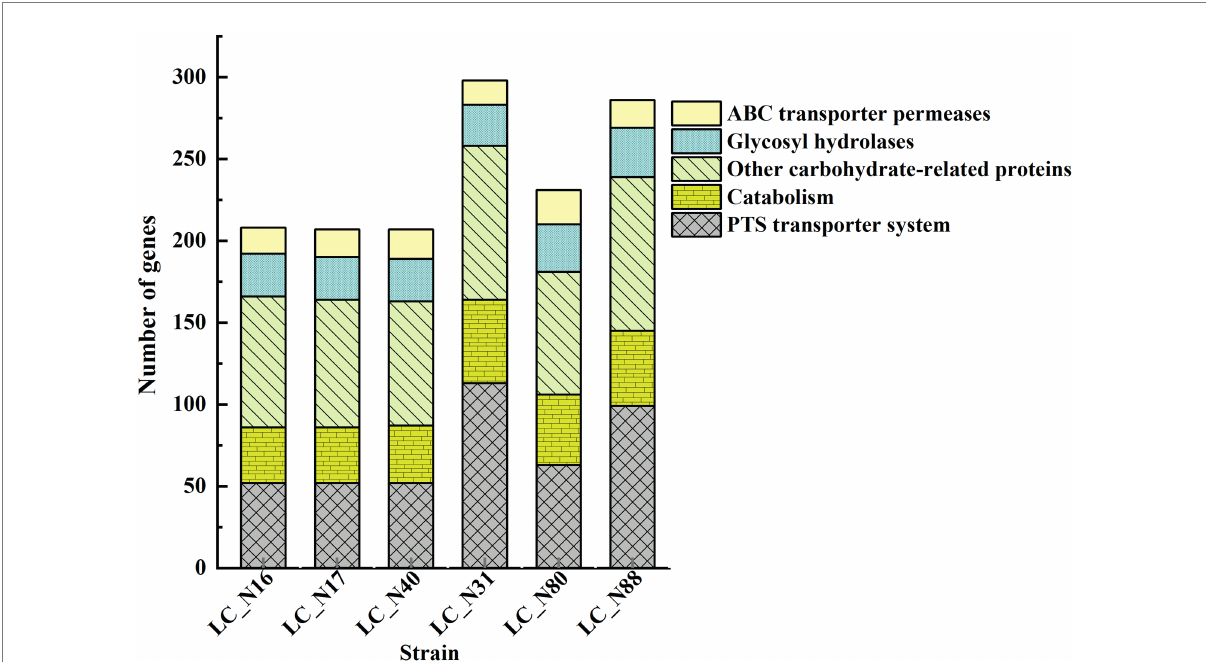
FIGURE 2 Functional analysis of genes in the exemplar HC and LC strains. Genes related to carbohydrate metabolism. Protein sequences were subjected to an orthology prediction using OrthoMCL with thresholds of: E-Value, 1E-5; percent identity cutoff, 0; and Markov inflation index, 1.5. Core genomes were mapped to the bacterial NCBI COGs and KEGG database to evaluate the main COG categories.